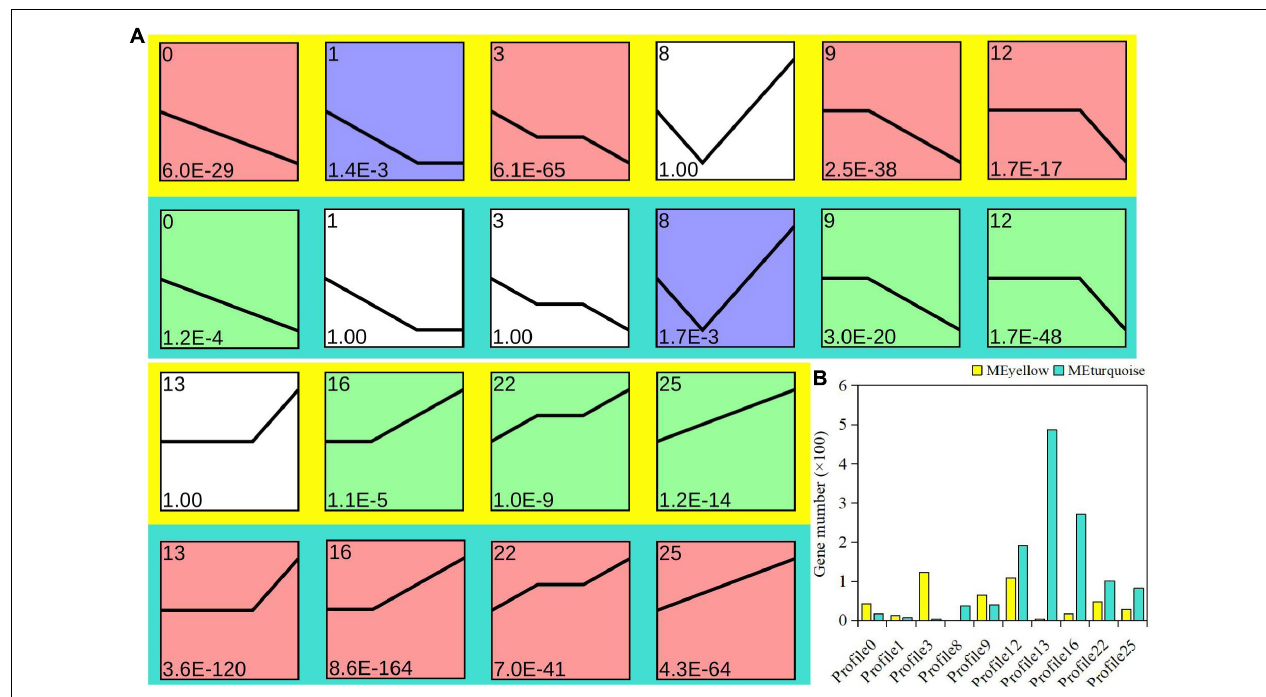
FIGURE 3 | Analysis of gene expression trend in yellow and turquoise modules. (A) Each plot shows the median expression value of all genes with a similar expression profile during Prunus mume bud dormancy. (B) Statistics of gene quantity in